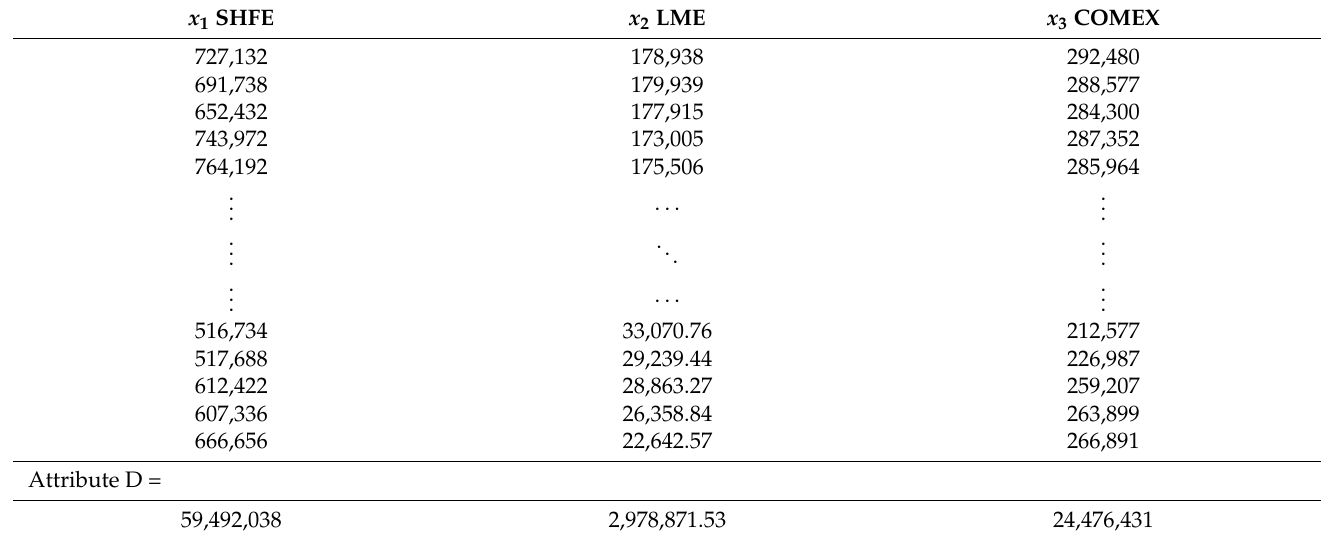
Table 9. Values of attribute “D” calculated using grey entropy and by importing data from three copper futures markets before the COVID-19 outbreak.